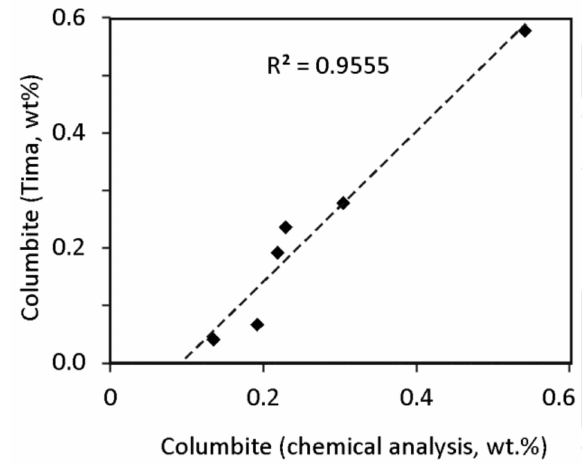
Figure 10. Comparison of the columbite content of the grinding products determined by TIMA and from the chemical